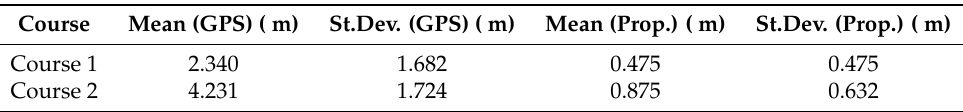
Figure 13. Results of localization in course 2. Table 3. Results of